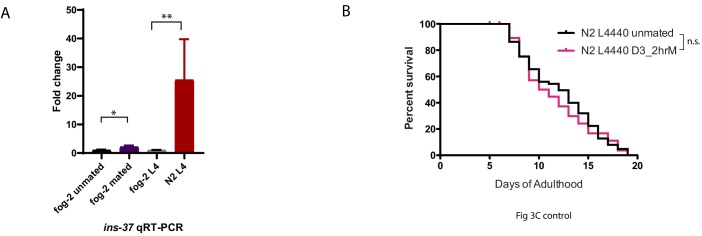
Ins-7 is highly up-regulated in L4 hermaphrodites with self-sperm.(A) qRT-PCR of ins-37. Ins-37 has an over 25-fold increase in N2 L4 hermaphrodites compared to fog-2 L4 hermaphrodites (same figure shown in Figure 3B). Mating has very little impact on ins-37 expression compared to the presence of self-sperm. Expression level of ins-37 increased about twofold in Day 2 mated fog-2 compared to unmated fog-2 (p=0.0137). (B) Control of Figure 3C,N2 hermaphrodites do not live shorter after 2 hr mating on day 3 of adulthood. N2 vector RNAi unmated: 12.1 ± 0.5 days; N2 vector RNAi mated: 11.6 ± 0.5 days, p=0.6335. .